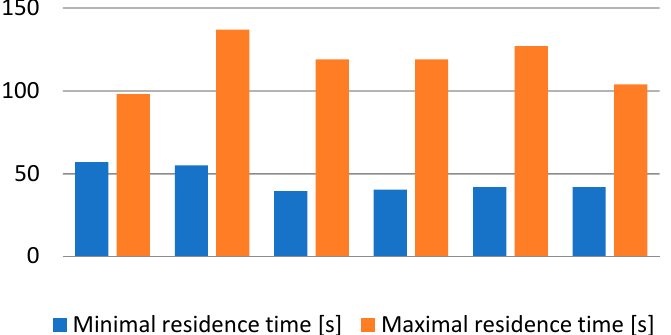
Figure 9. Graphical comparison of residence times of all tested configurations.